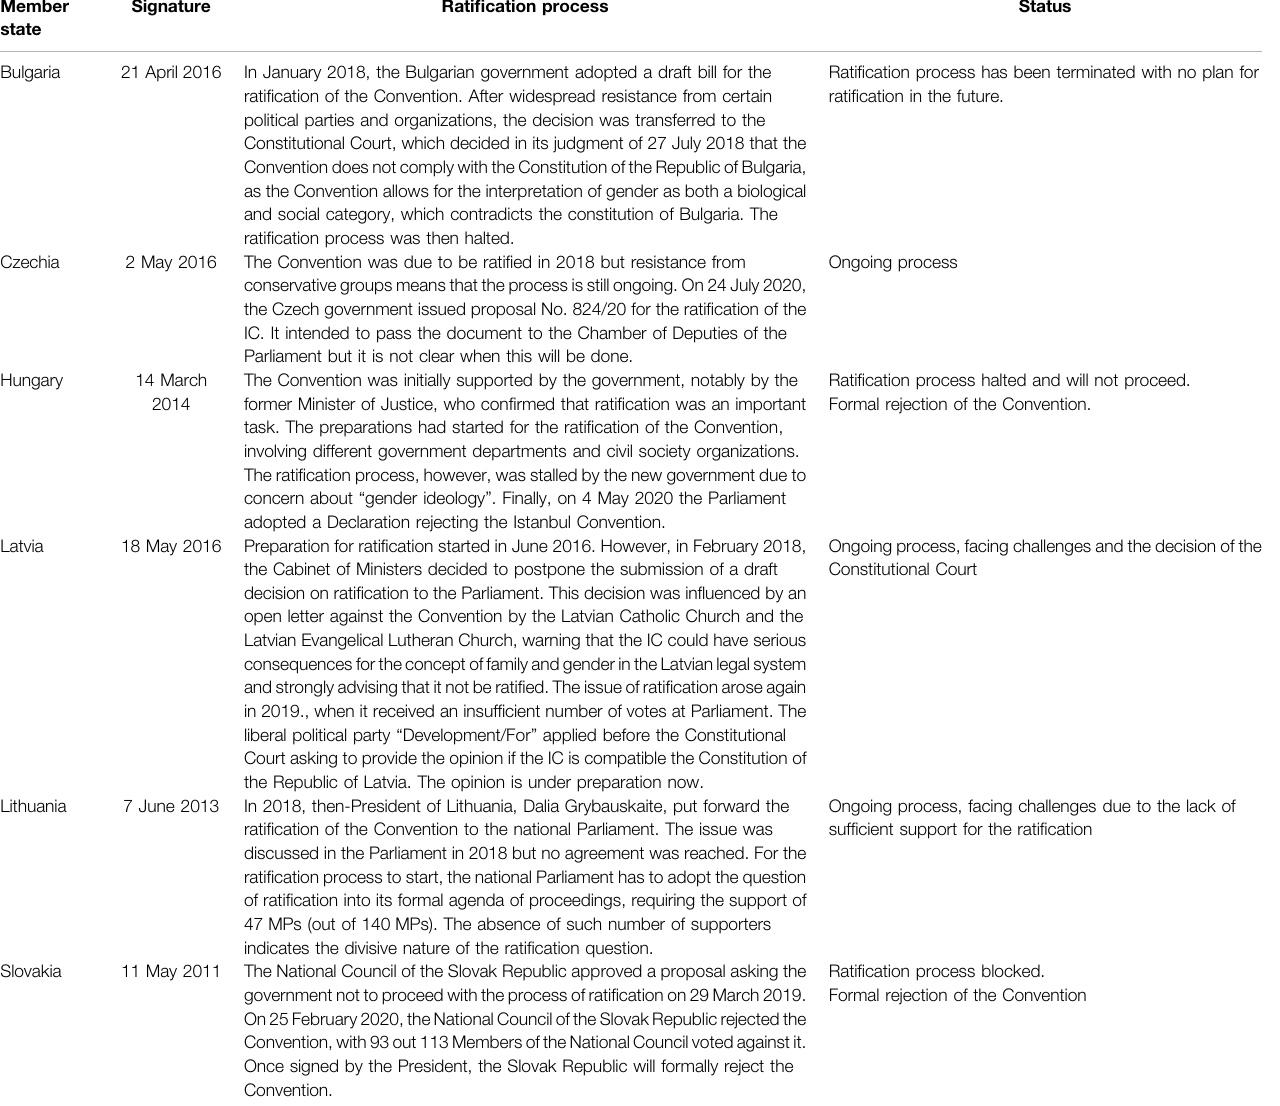
TABLE 4 | Overview of rati fi cation process in six non-ratifying countries (Meurens et al.,